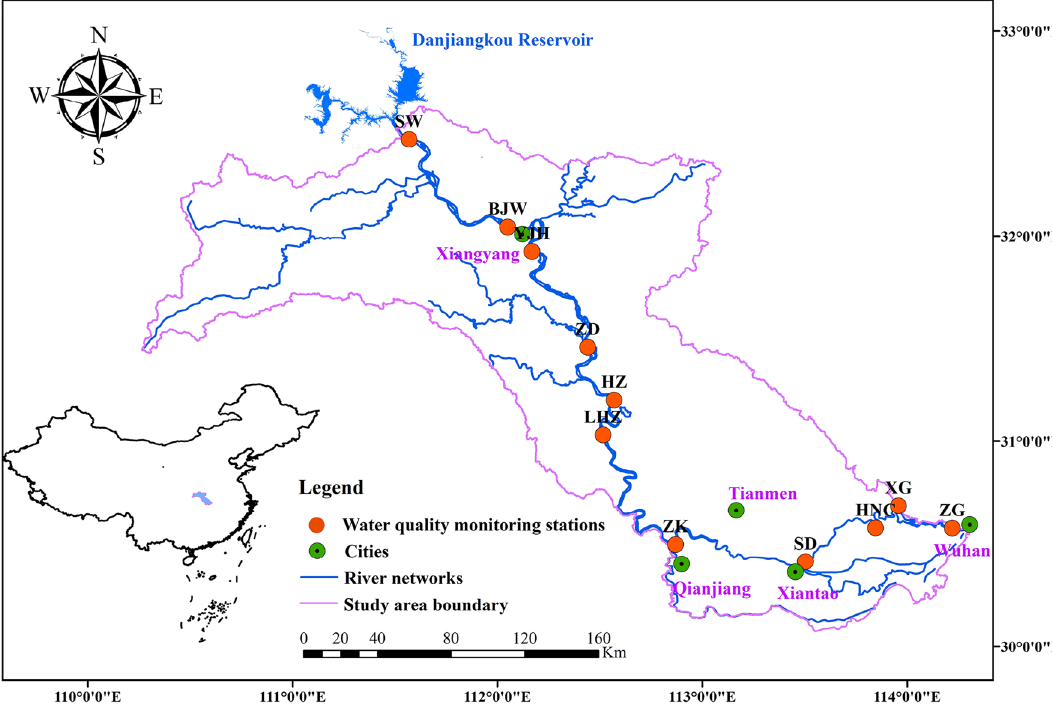
Figure 1. Location of the water monitoring stations in the middle and lower Han River basin. (This figure is generated by ArcGIS10.2 software. URL link: http:// www. arcgi sonli ne.